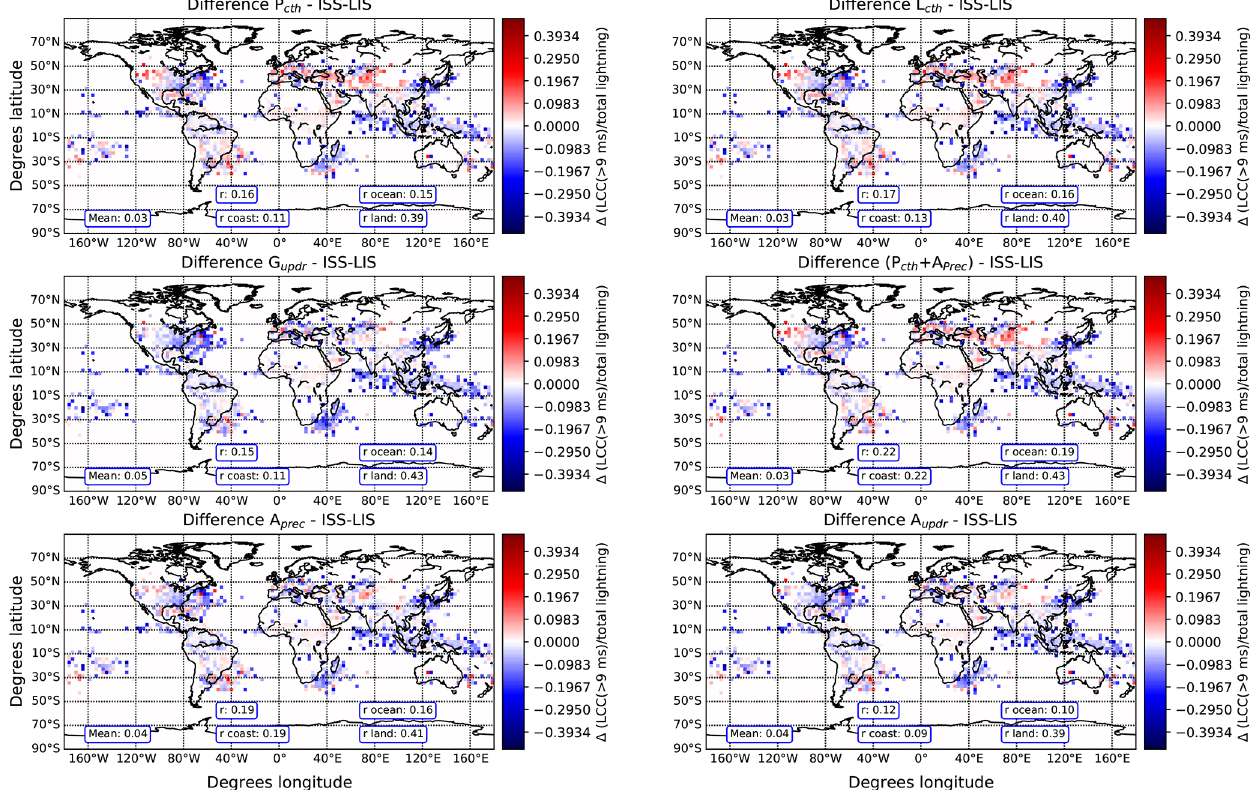
Figure 10. Difference between the observed and simulated ratio of LCC( > 9ms) lightning to total lightning density i March, April, and May using different lightning parameterizations. Positive values indicate that the model overestimates the ratio. The calculated global, land, and ocean spatial correlation coefficients r are